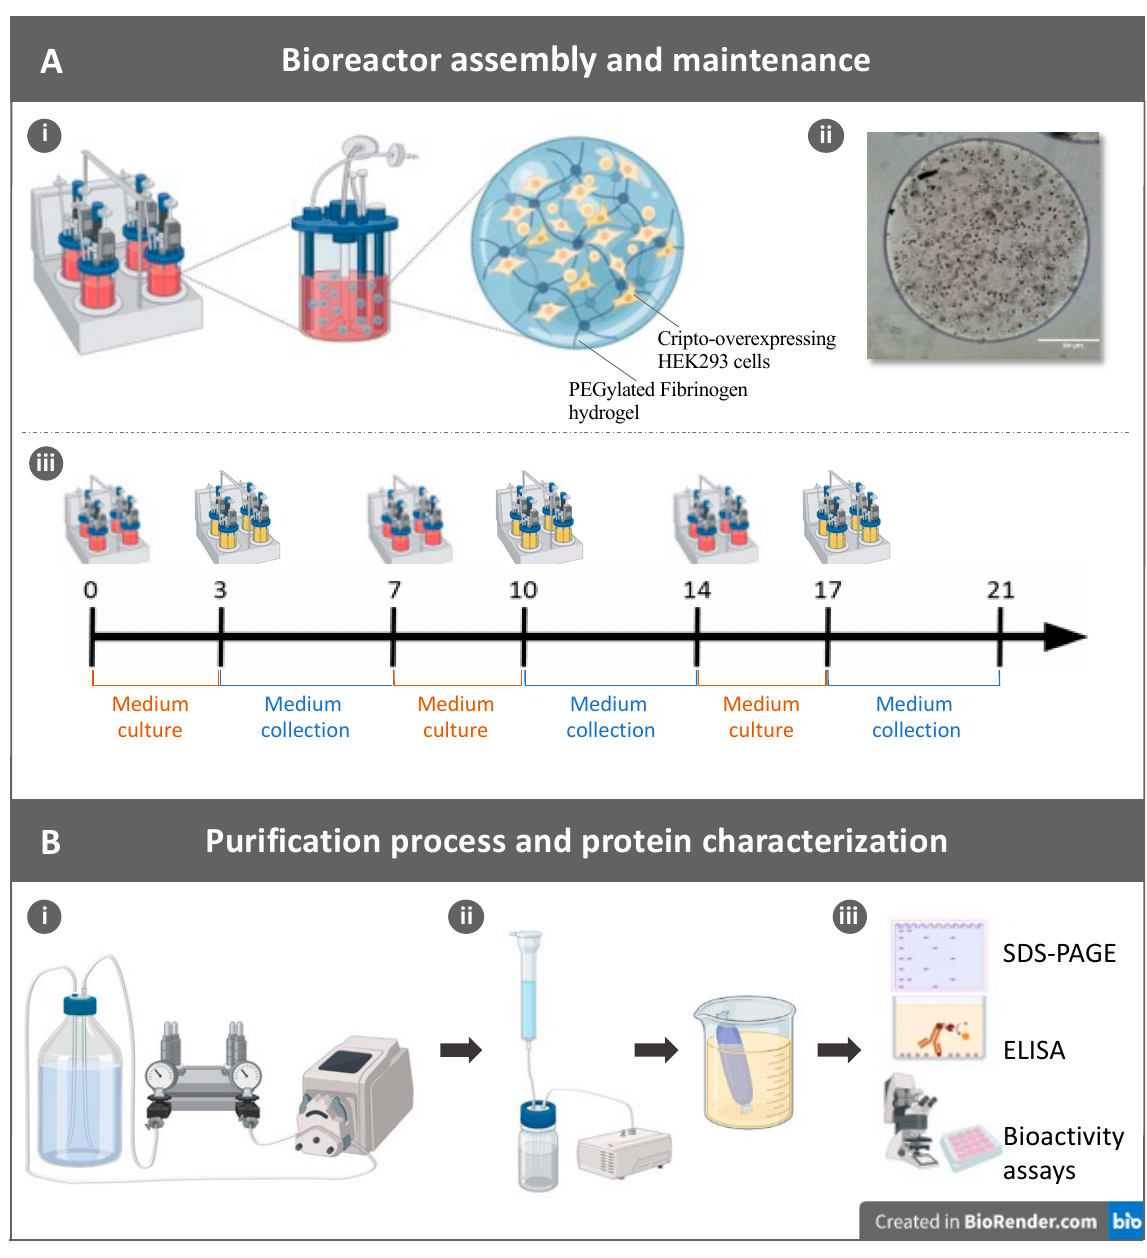
Figure 1. Schematic illustration of PF microcarriers and the bioprocessing procedure for making Cripto protein. ( A ) i : A set of bioreactors were used for Cripto production; each bioreactor cultivates microcarriers made of PEG-fibrinogen (PF) hydrogel containing Cripto-overexpressing HEK293